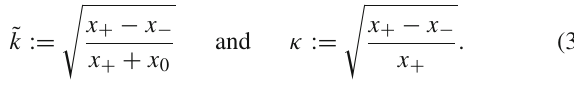
/ M 2 : (from bot- dS P